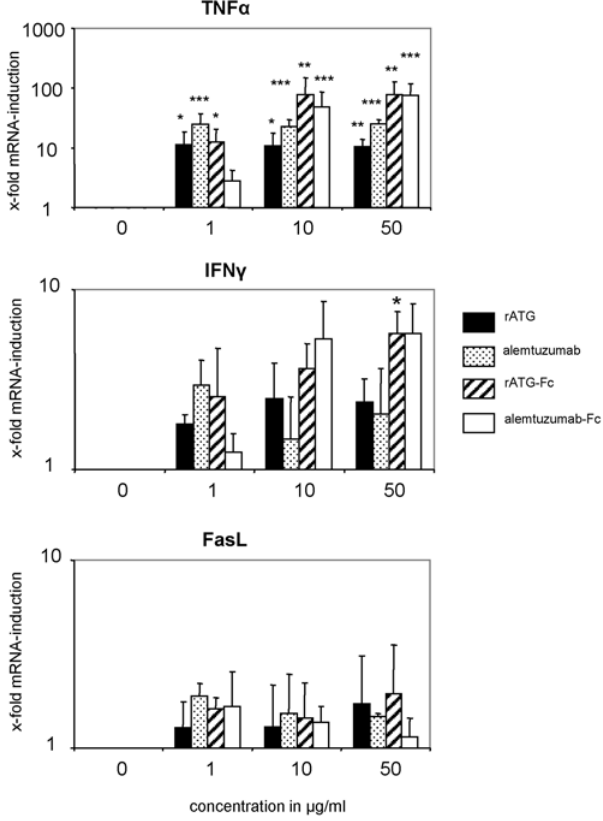
Figure 9. The Fc-part of rATG and alemtuzumab is sufficient to induce cytokine release in whole blood samples. Whole blood samples were treated for 2 hours with 1, 10 and 50 m g/ml of intact antibody or Fc-parts of rATG and alemtuzumab. After red blood cell lysis induction of TNF a , IFN c and FasL mRNA was observed. Values demonstrate the results relativized to untreated controls (2 2 DD ct ) and are displayed as means of four independent experiments. Asterisks (*) indicate significant values compared to untreated controls: * p , 0.05, **p , 0.01, ***p , 0.001.